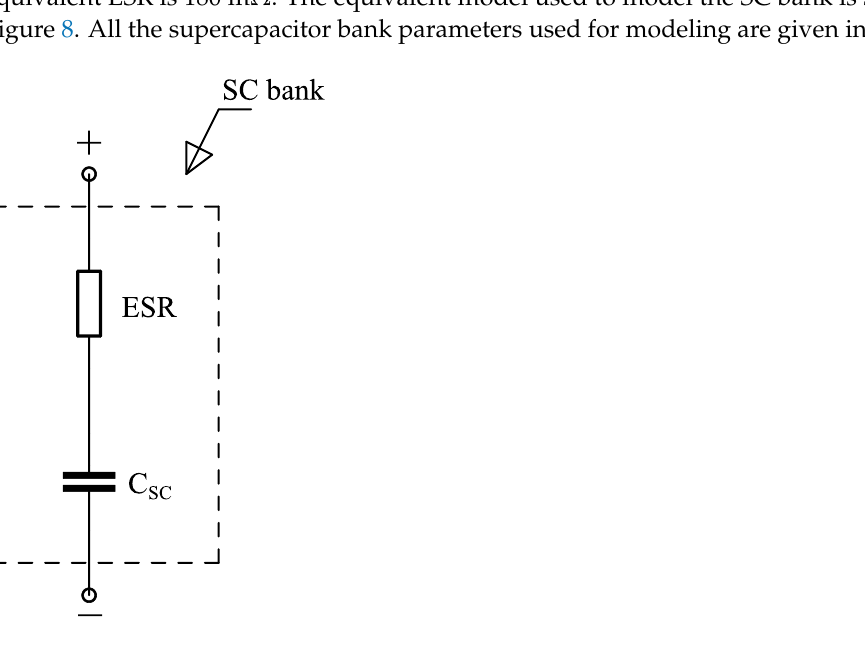
Figure 8. Equivalent model of the SC bank. Table 2. SC bank